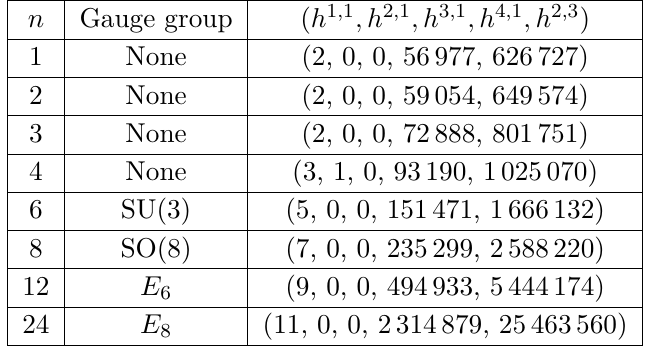
Table 4 . The Hodge numbers of the generic elliptic CY5 over a smooth base B n . The non-Higgsable gauge group is also